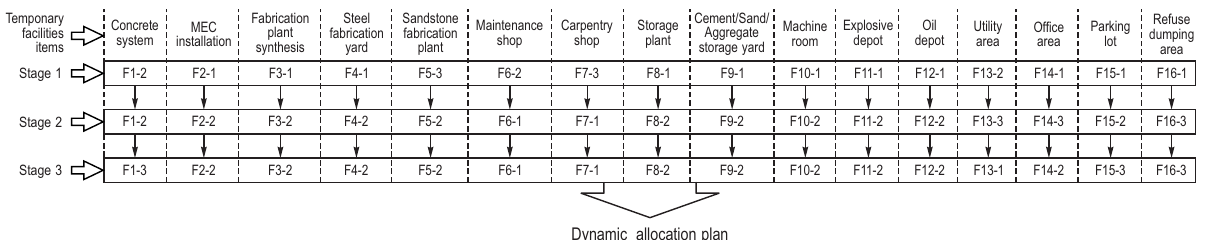
Fig. 6. Dynamic allocation plan for the DDTFLPP of the Jinping-II hydropower station